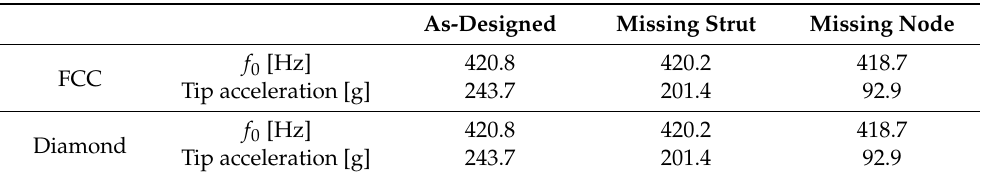
Table 5. Reduction of frequency and tip acceleration under resonant conditions through numerical models.